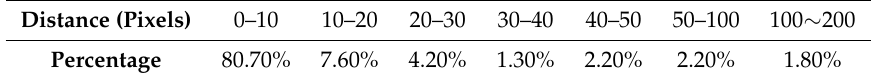
Table 2. Microaneurysm and blood vessel distance distribution.